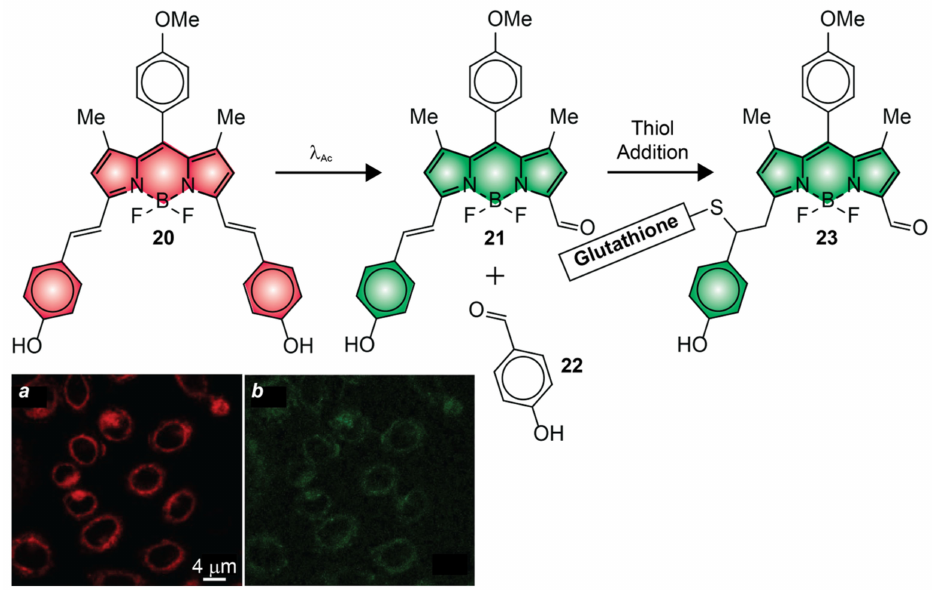
Figure 12. CLSM images of live HeLa cells, labeled with 20 , recorded before ( a ) and after ( b ) photoactivation [adapted with permission from Ref.